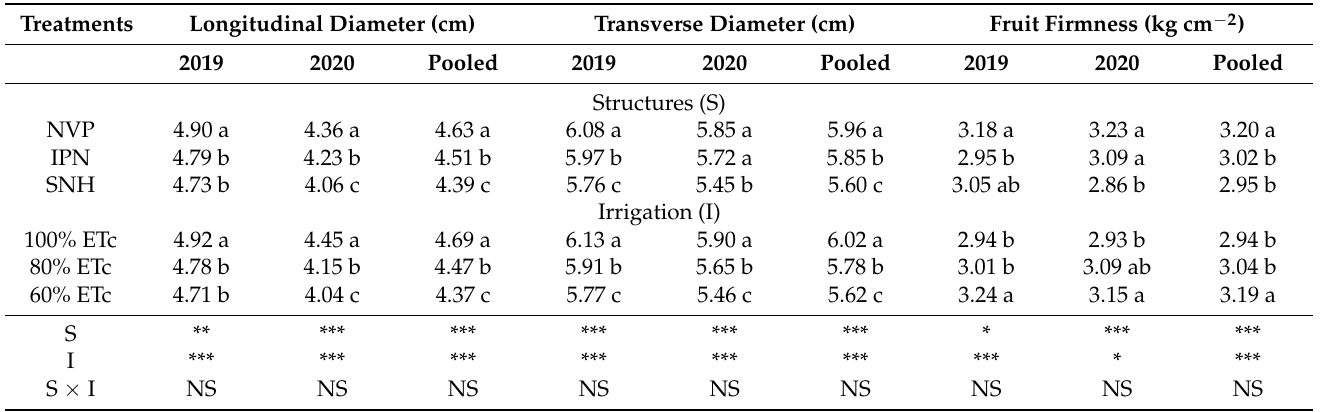
NS NS NS NS NS NS NS